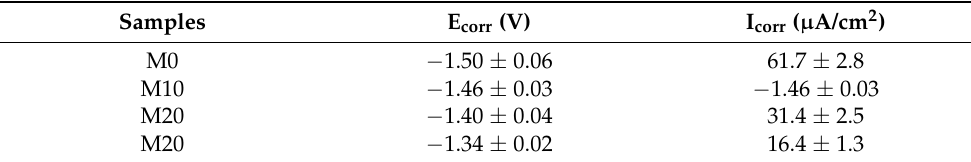
Table 2. Tafel fitting results derived from the polarization curves of laser-sintered